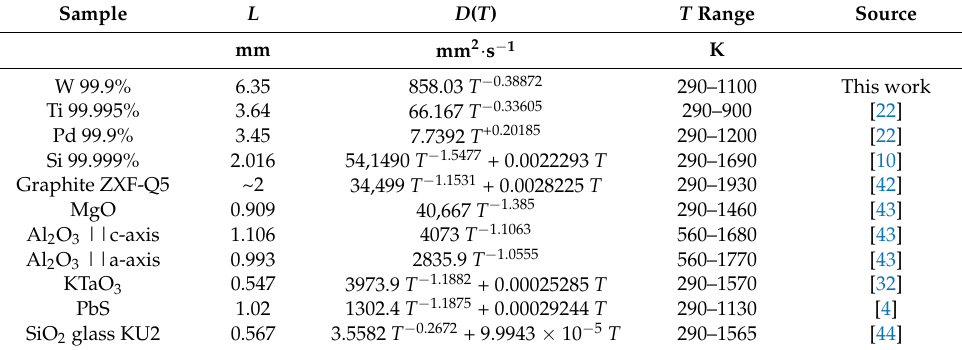
Table 1. Examples of fits 1 to thermal diffusivity of nearly pure materials.